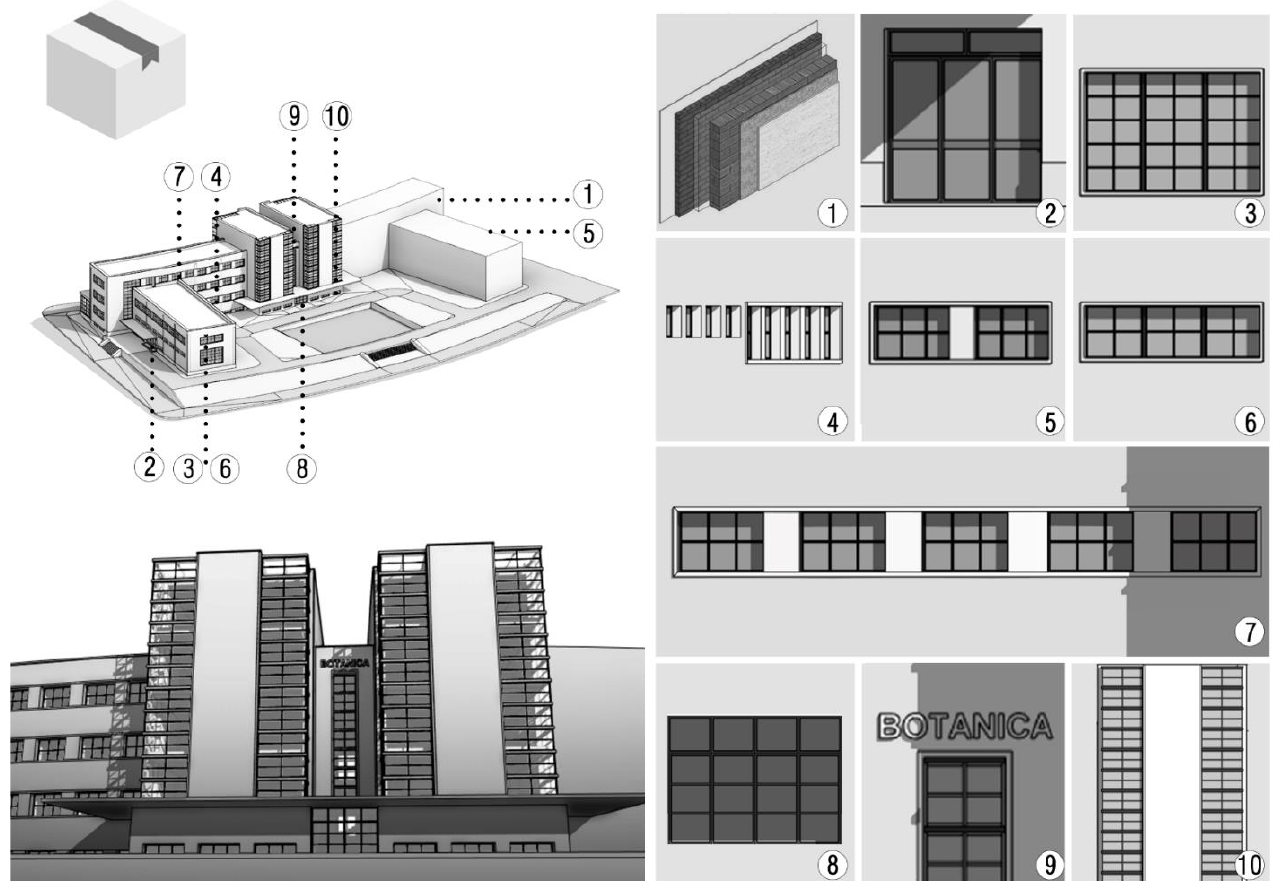
Figure 9. The Botany Institute. Detailed view of constructive solutions for external surfaces ( right ) and their localization in the BIM model ( left ).